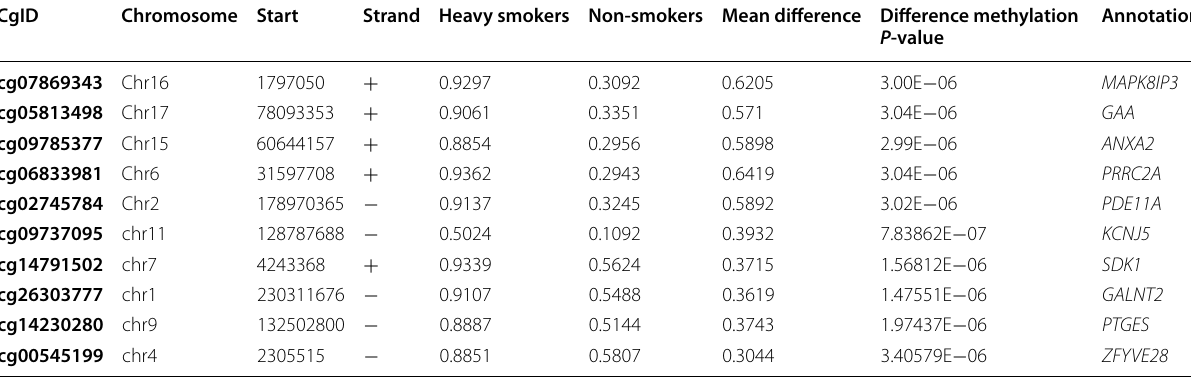
Table 2 Location of CpG dinucleotides that differ in their spermatozoa DNA methylation levels in heavy smokers compared to non- smokers ( n 30) = CgID Chromosome